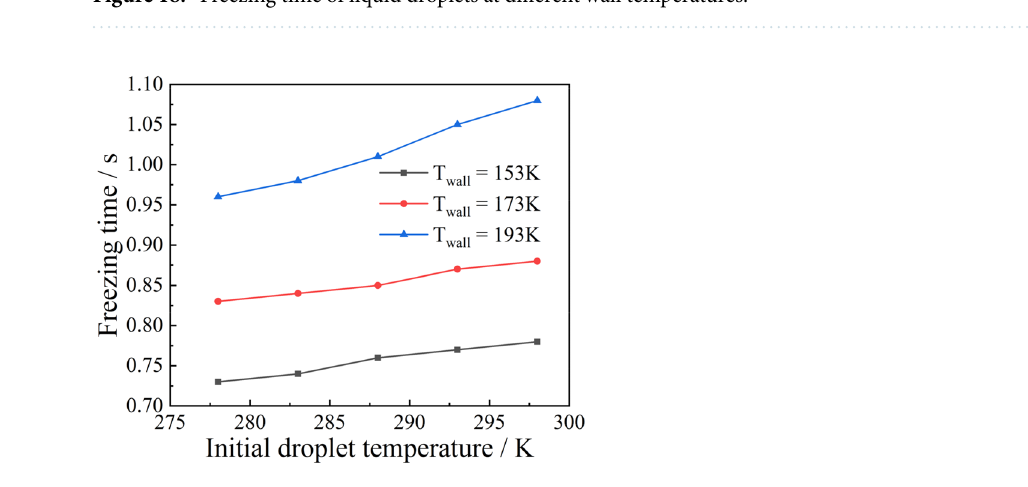
Figure 18. Freezing time of liquid droplets at different wall temperatures.